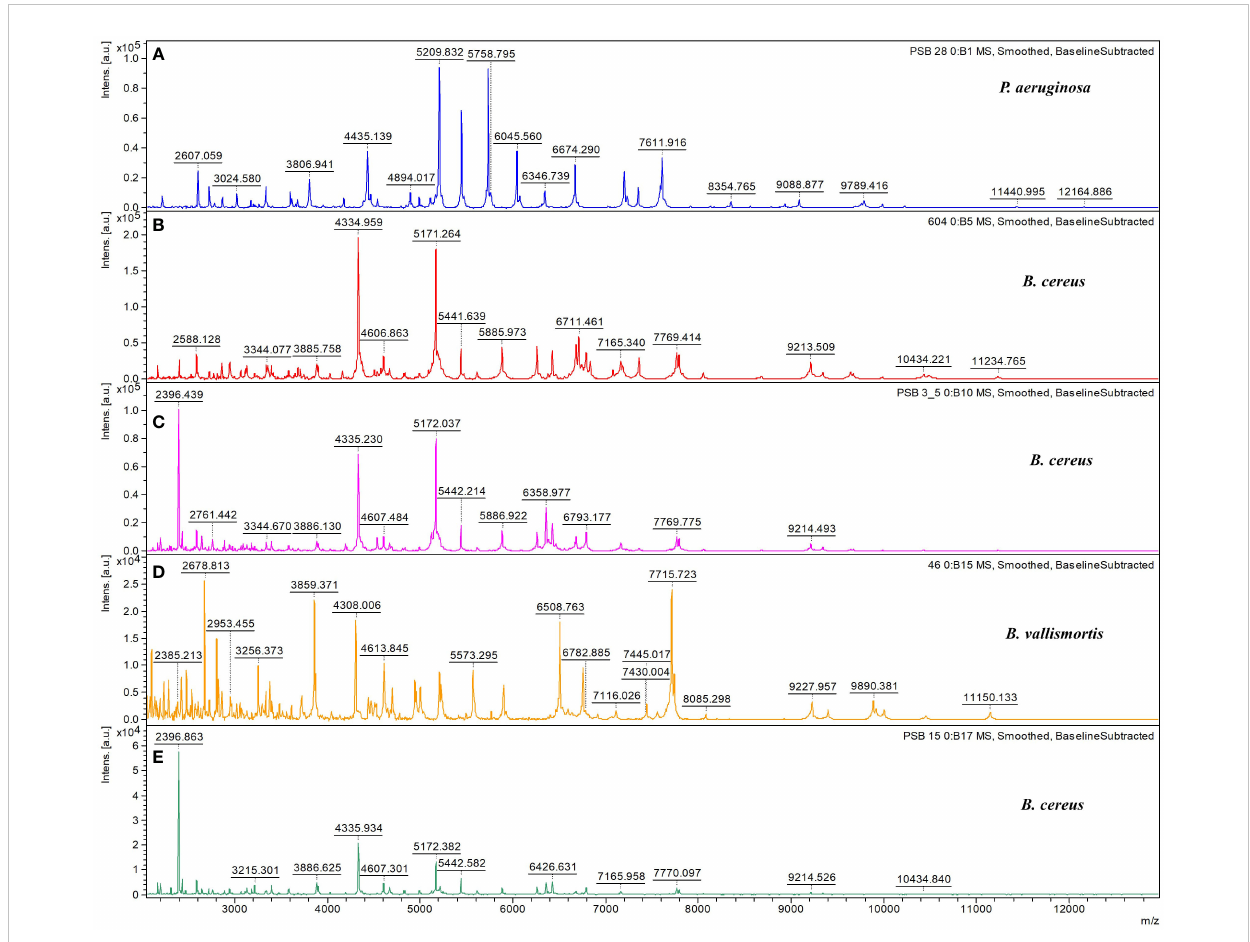
FIGURE 1 Characteristic MALDI – TOF/TOF MS spectra. Characteristic spectra of (A) Pseudomonas aeruginosa , (B) Bacillus cereus , (C) B cereus , (D) B vallismortis , and (E) B cereus generated using the Bruker BioTyper MALDI – TOF/TOF MS system. Absolute intensities of ions are shown on the y – axis, and the masses ( m / z ) of ions are shown on the x – axis. The m / z values represent the mass – to – charge